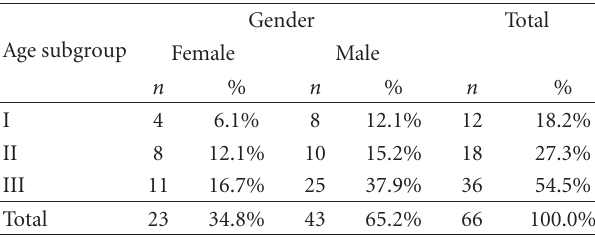
Table 2: Cleft group (explanation of age-subgroups see Table 1).